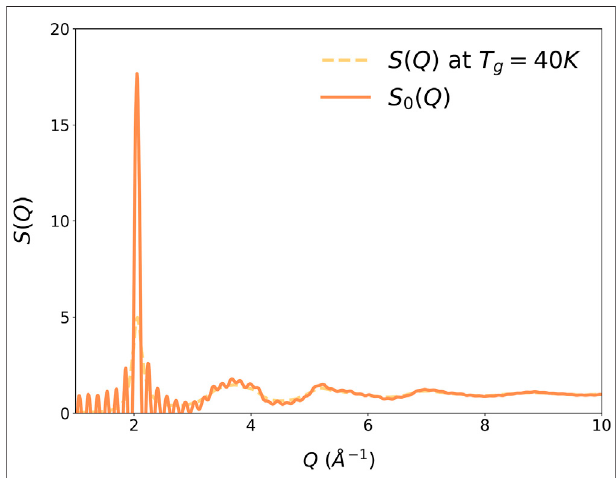
FIGURE 4 | The S ( Q ) of liquid Argon at T g = 40 K. The height of the fi rst peak depends on the model size, and extrapolates to a δ -function for a macroscopic model.